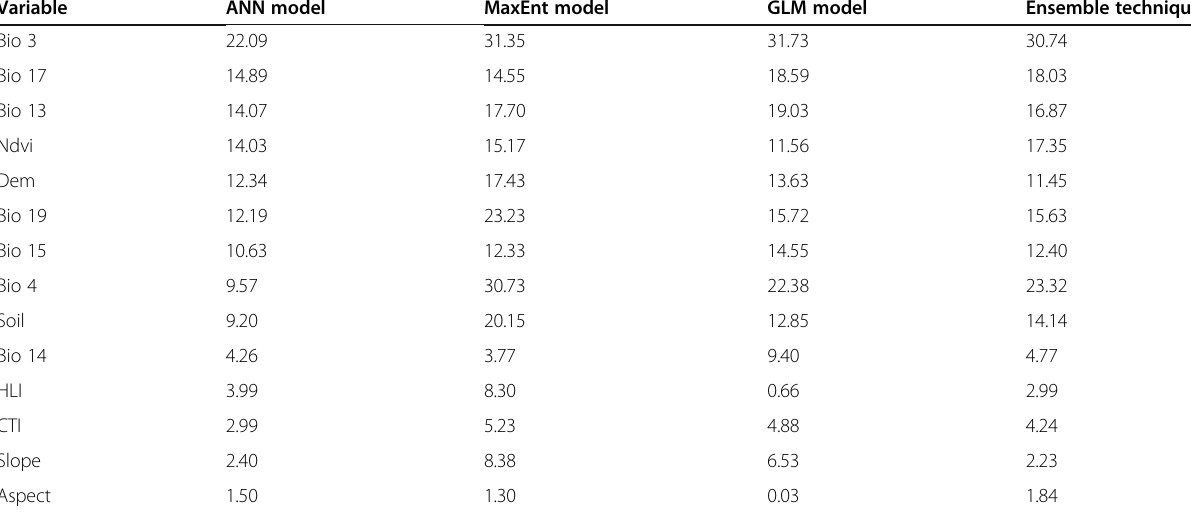
Table 4 Importance of environmental variables (%) used in predictive models by the random forest regression analysis Variable